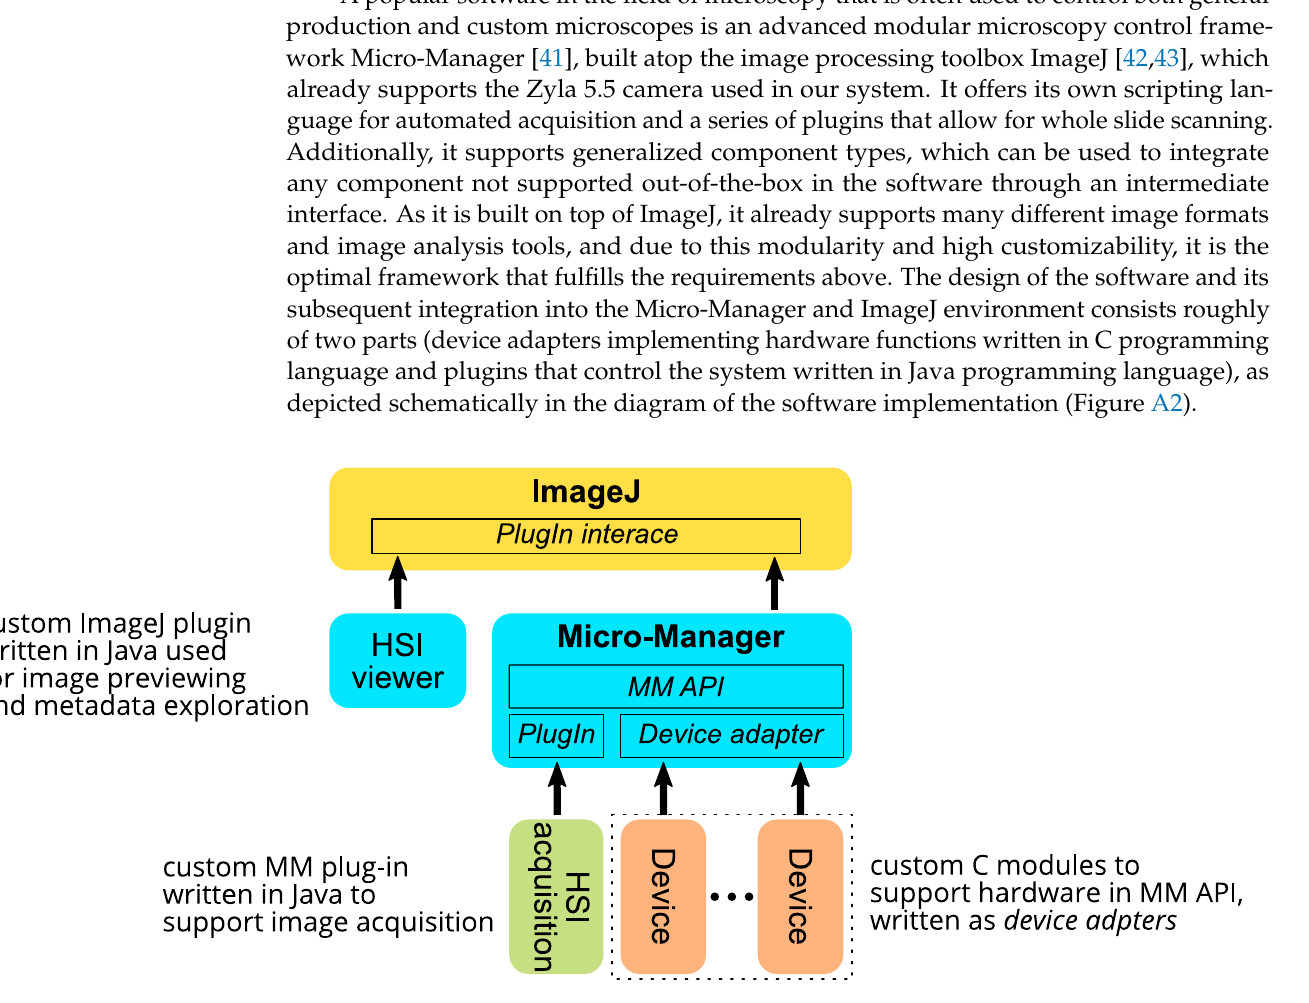
Figure A2. The software architecture of the control system. The main framework is ImageJ, which runs either a custom HSI viewer plugin written in Java or the Micro-Manager (MM) environment. To communicate with Micro-Manager API, each device has a C class that implements the Micro-Manager device adapter interface, communicating with Micro-Manager on one side and the device on the other. For acquisition control, a separate plugin written in Java implementing Micro-Manager plugin architecture is used. This plugin can access all the devices in the configured system via the general Micro-Manager API.